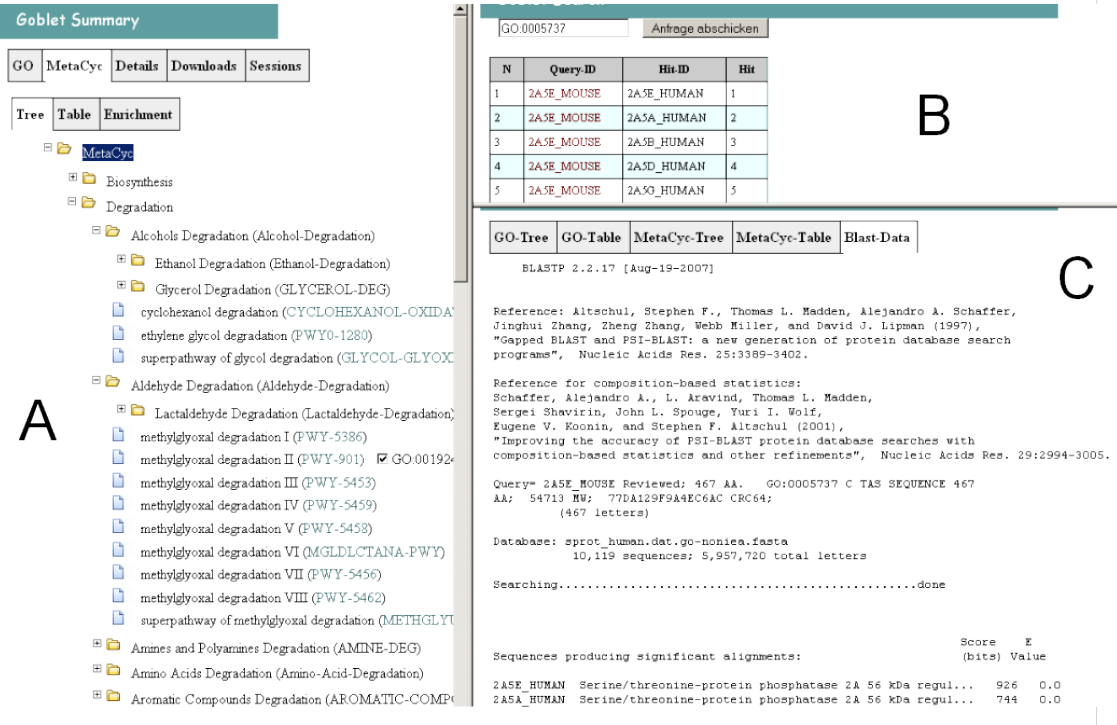
Figure 3: GOblet result window, summary frame (A), search frame (B), and detailed result